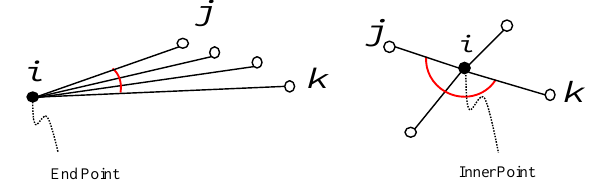
Figure 3. Neighbors' distribution at the endpoint and the inner